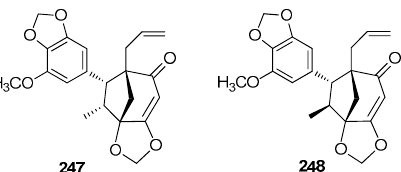
Figure 14. Chemical structures of 7.1’,8.3’-cycloneolignans.